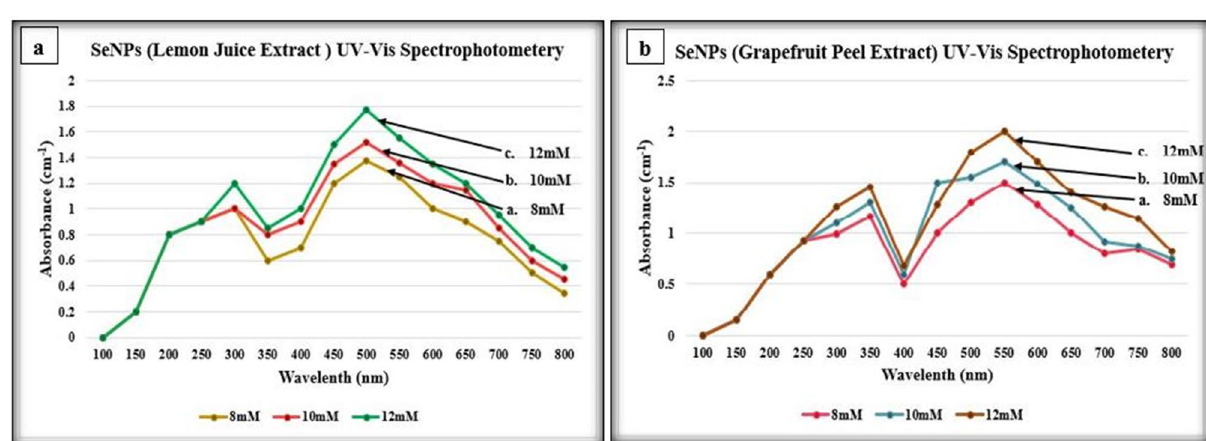
Figure 3. UV–Vis spectrophotometry analysis of SeNPs synthesized from Citrus limon (Lemon); ( a ) fresh juice extract, ( b ) fresh peels